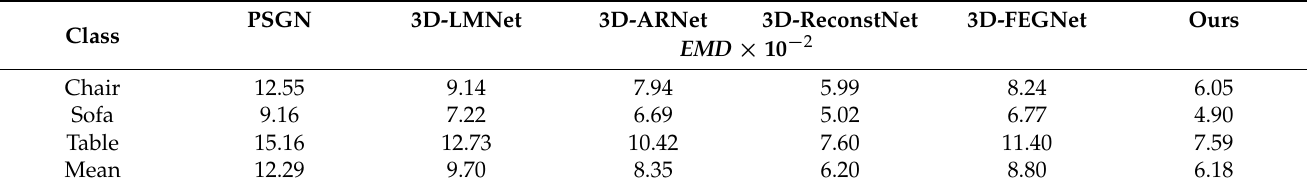
Table 7. Reconstruction results on Pix3D evaluated by